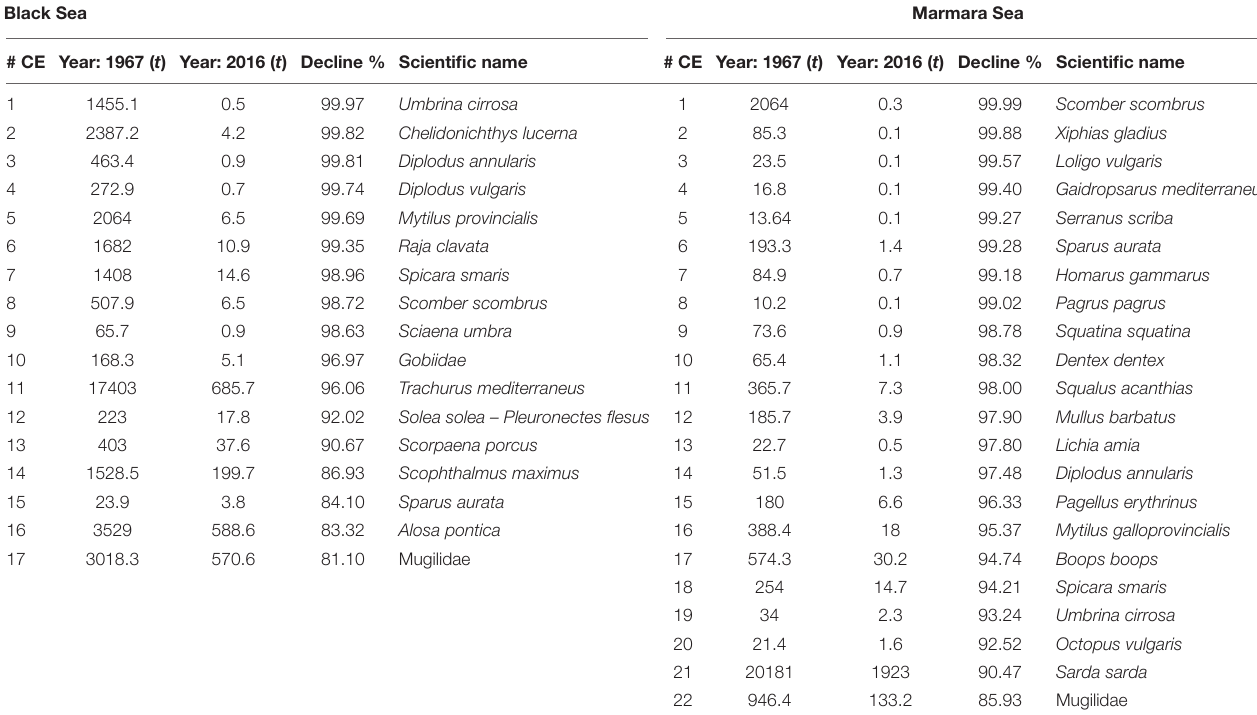
TABLE 2 | List of commercially extinct (CE) species for Black Sea and Marmara Sea over 50 years using 1967 and 2016 catch amounts, and% decline by taxa by decreasing percentage amount. Black Sea